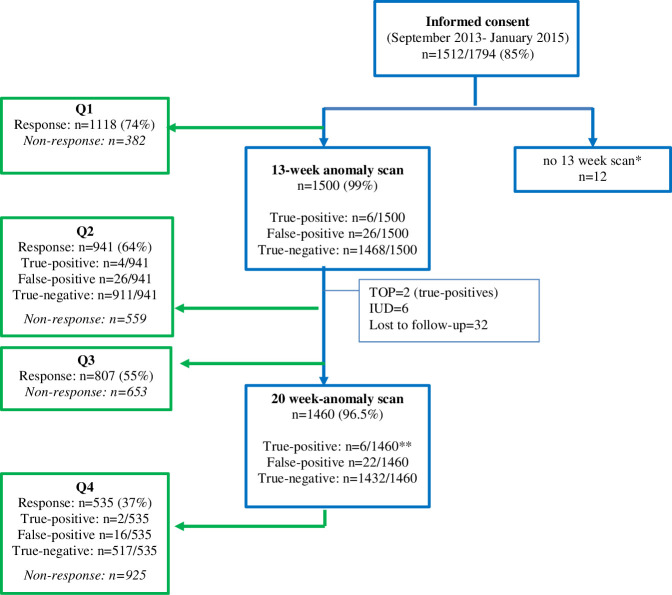
Study profile.*Fetal loss, lost to follow-up. **The 6 abnormalities detected at the 20-week anomaly scans different from those found at the 13-week anomaly scans. Blue: women who initially consented to participate. Green: women who filled in the questionnaires.